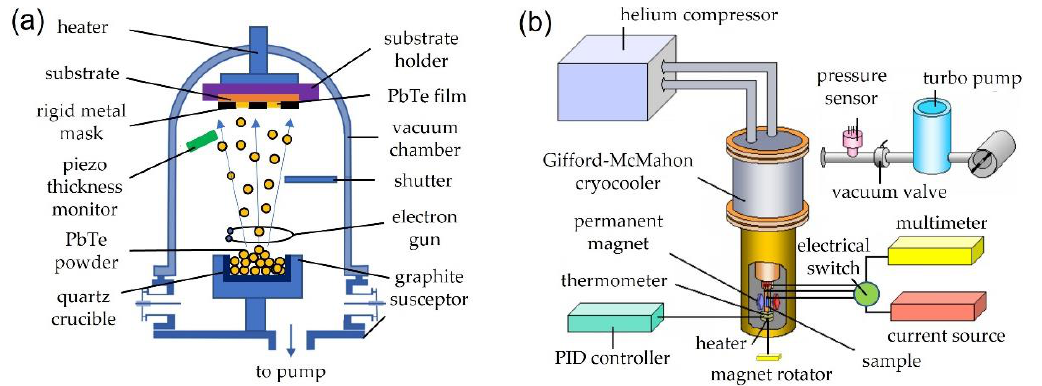
Figure 1. ( a ) The schematic view of the electron gun vapor deposition system. ( b ) Schematic view of set up for measurements of transport properties in PbTe:In films.